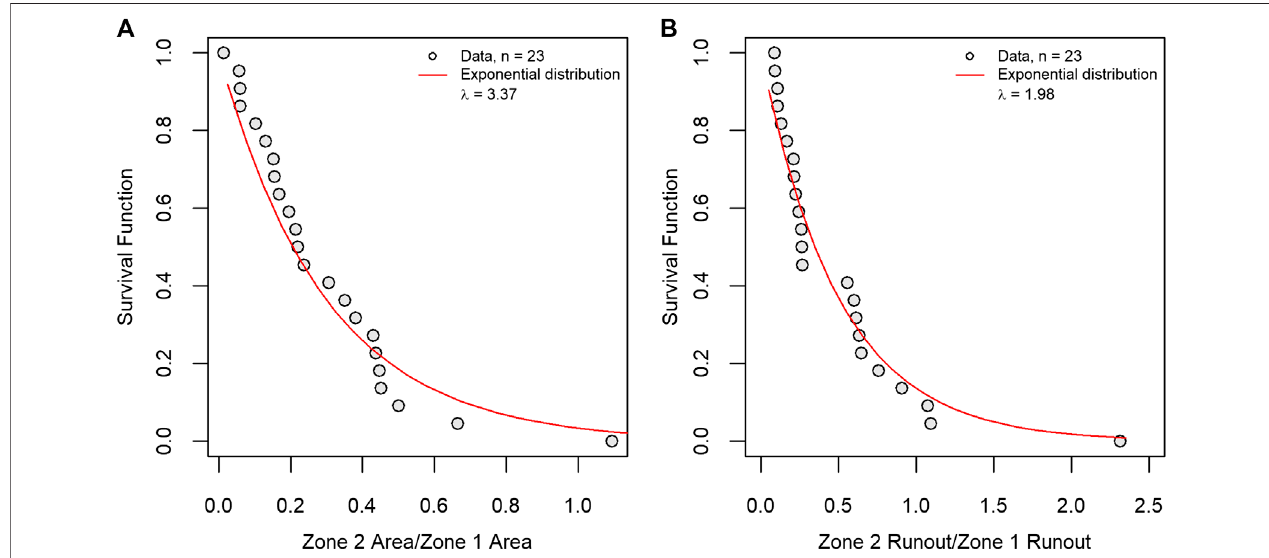
FIGURE9|(A) RelationshipbetweenZone2andZone1areasforeventswhereamass fl owwasobserved,andsurvivalfunctionfortheZone2overZone1areas, (B) relationshipbetweenZone2andZone1runoutdistanceforeventswhereamass fl owwasobserved,andsurvivalfunctionfortheZone2overZone1runoutlengths.